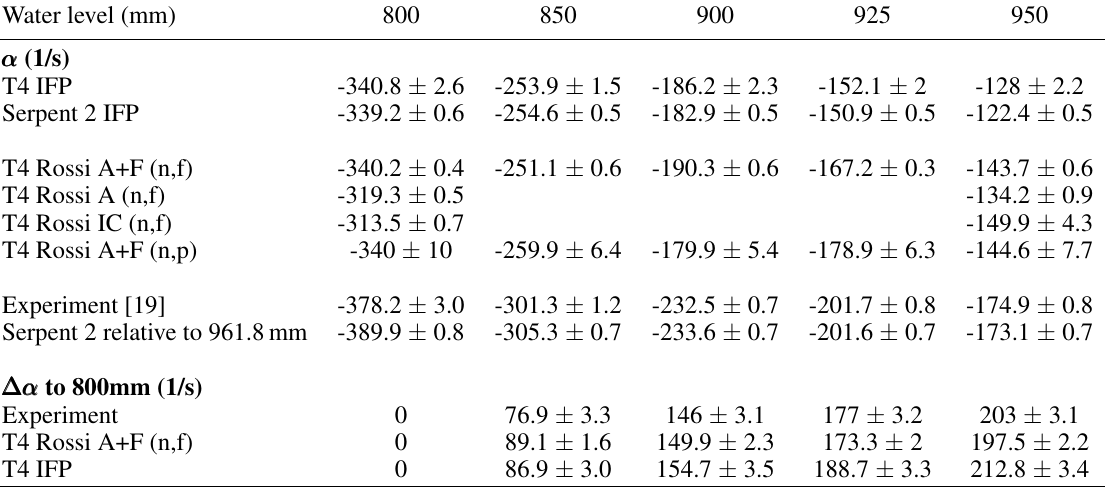
Table 1: Comparison of the prompt decay constant α for different water levels of CROCUS for experiments, IFP predicted values for Serpent 2 and T4, and T4 Noise. The fit results for T4 noise using Rossi or Feynman distributions on full core (n,f) or detector (n,p) tracking are further differentiated by their simulation mode: implicit capture (IC), analog (A), and analog with FREYA fission (A+F). The uncertainties listed arise either from statistical estimates for the simulations or 95% confidence bounds on fits for the noise methods. We also compare relative ∆ α values with 800 mm as reference for the experiments, T4 Noise, and T4 IFP. The uncertainties are propagated from the aforementioned values. Water level (mm)